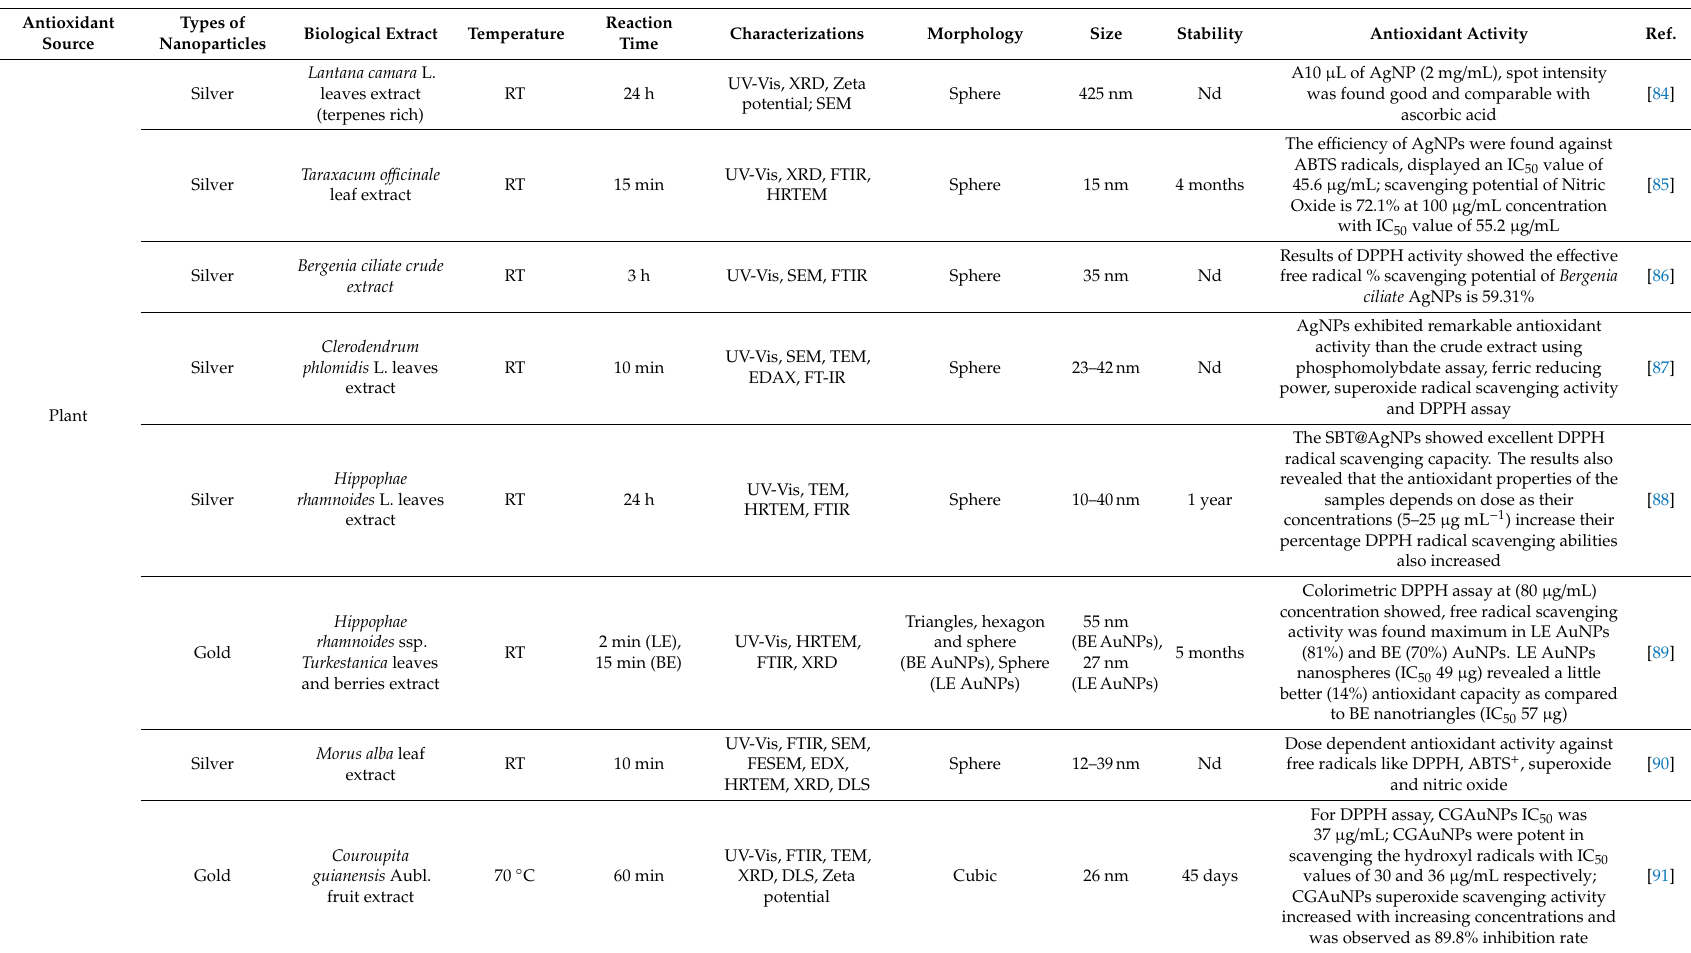
Table 3. Antioxidant potential of functionalized